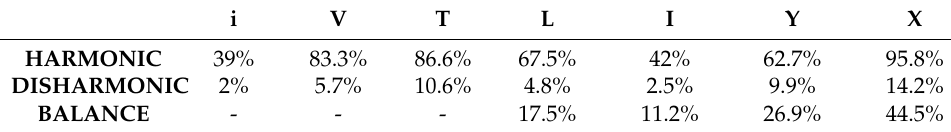
Table 1. Covered areas for each experiment related to the porcelain owl